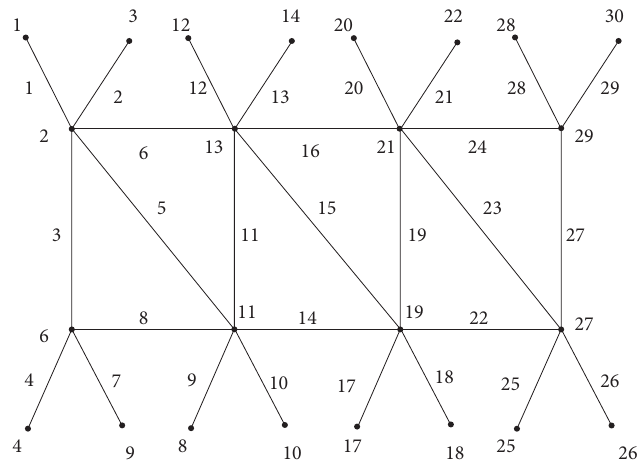
Figure 10: A classical mean labeling of TL